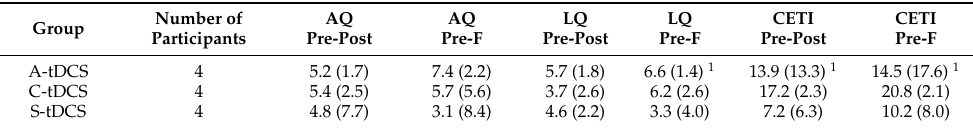
Table 3. Mean (Std Dev) gains in language performance on the Western Aphasia Battery-Revised (WAB-R) and caregiver-reported communication effectiveness by group at both post-treatment and six-week